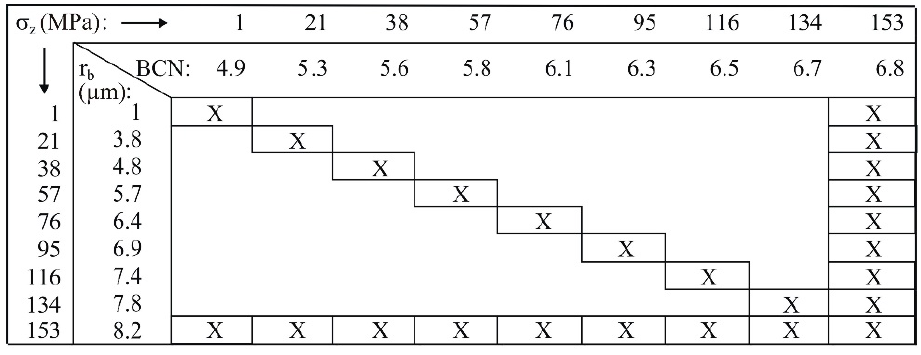
Figure 14. Scheme of simulation variants.